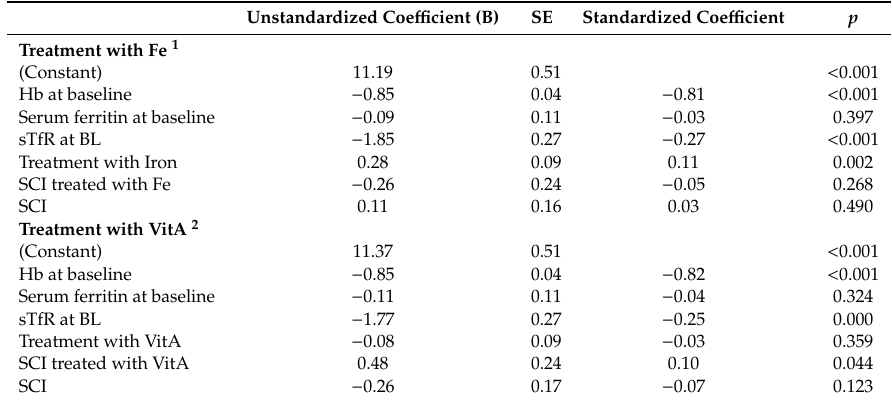
Table 3. Determinants for Hb changes from baseline to endline of 12 weeks Intervention. Unstandardized Coe ffi cient (B)